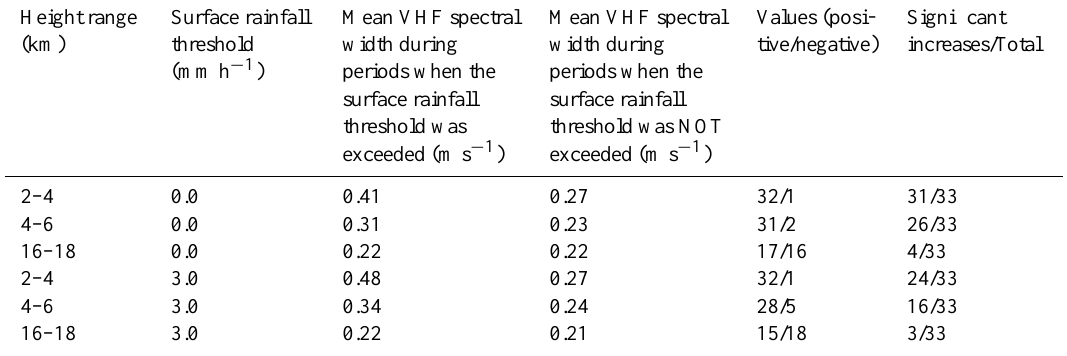
Table 2. The mean VHF spectral width is shown averaged over the height range indicated during periods where the indicated rainfall threshold was and was not exceeded. In addition, the number of positive and negative changes are shown in the spectral width as well as the number of significant increases in the spectral width associated with periods of surface rainfall above the indicated threshold. The surface rainfall is observed by a tipping bucket rain gauge co-located with the VHF